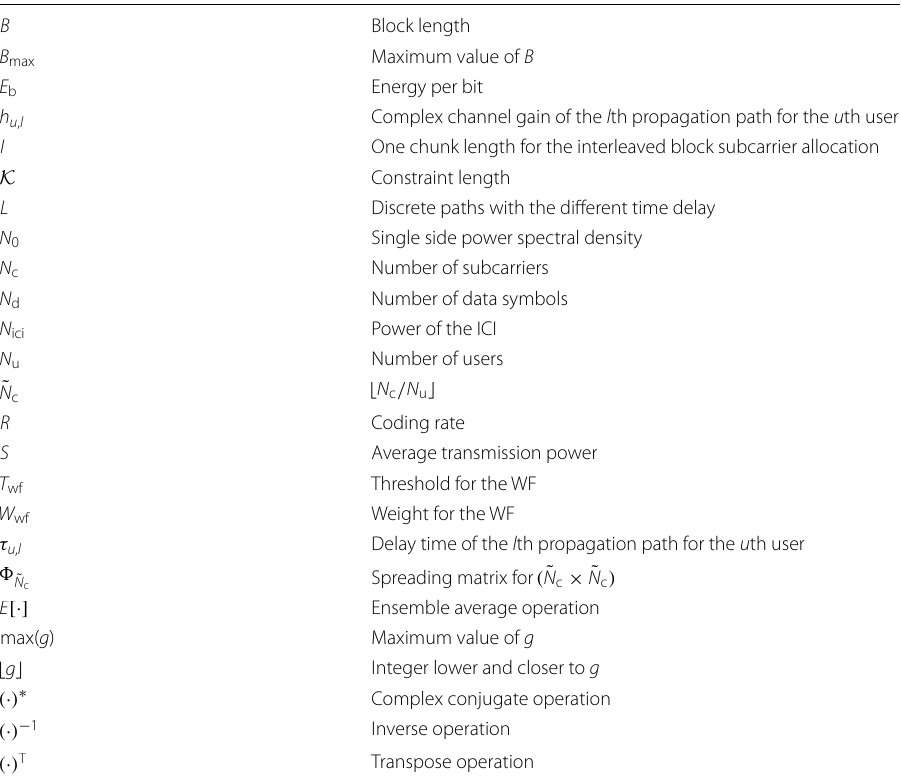
Table 2 Notation for the